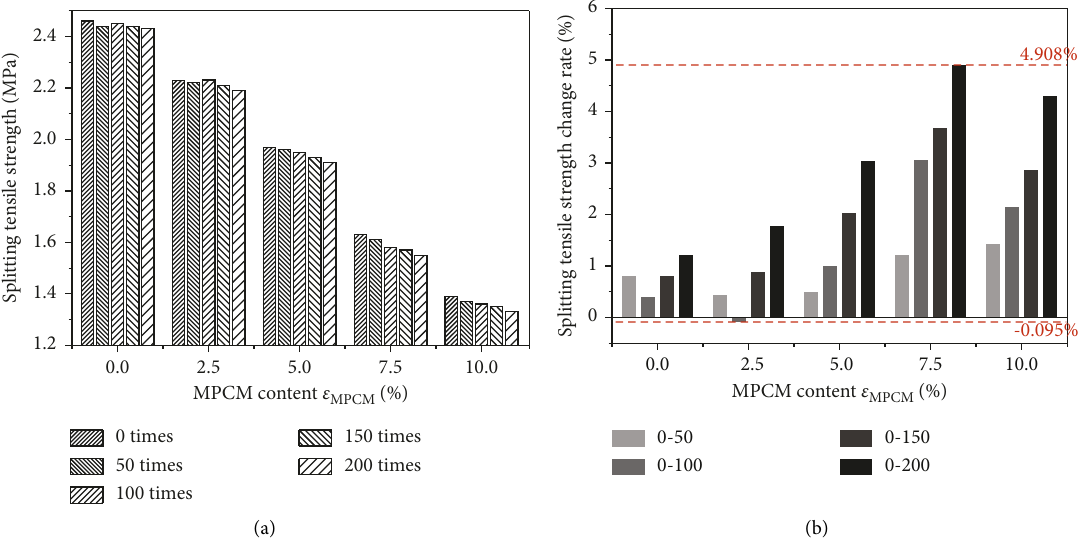
Figure 8: The relation curve between the numbers of phase-change cycle and splitting tensile strength with the numbers of phase-change cycle. (a) The change law of splitting tensile strength. (b) The change law of splitting tensile strength variation with the numbers of the phase- change